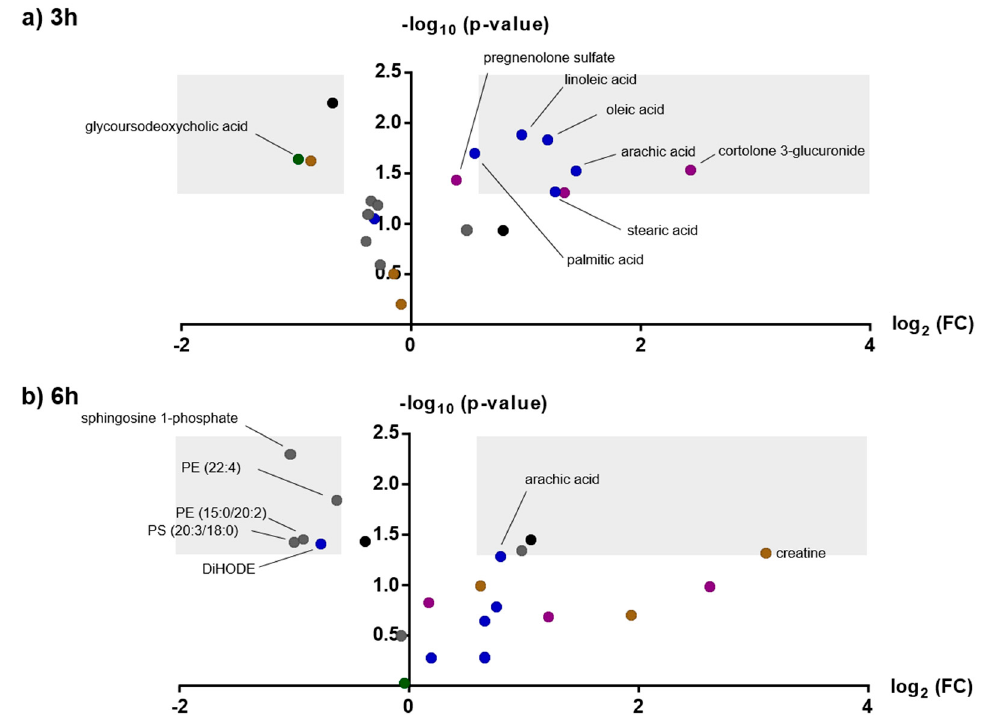
Figure 4. Volcano plots of selected, identified features 3 h ( a ) and 6 h ( b ) after nasal mephedrone consumption. Different compound classes are depicted in different colors: long-chain fatty acids (dark blue), bile acids (green), amino acids (brown), phospholipids (grey). All other features remained black. Compounds in light grey areas can be considered as particularly interesting ( − log10 p -value > 1.3; log2 foldchange > 0.6 or < − 0.6).